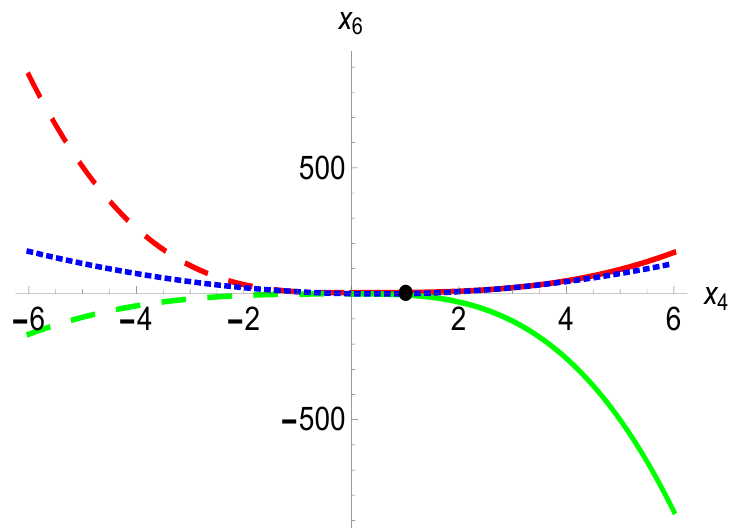
Figure 4. Region of stability in the x 4 (cid:0) x 6 plane at j (cid:21) j = 1 . The solid red curve represents 2 x 6 (cid:0) (cid:30) + + x 3 = 0 while the solid green one corresponds to x 6 (cid:0) (cid:30) (cid:0) + x 3 = 0. The dashed red 4 (cid:0) 4 + curve represents the line x 6 (cid:0) (cid:30) + + x 3 < 0 while the green dashed one denotes x 6 (cid:0) (cid:30) (cid:0) + x 3 = 0. 4 + 4 (cid:0) The region between the solid red and solid green curves, and the region between the dashed red and dashed green curves de(cid:12)ne the region of stability. The blue line is the set of N = 1 theories while the black dot is the N = 2 theory. Note that all susy theories lie within the stability regime.